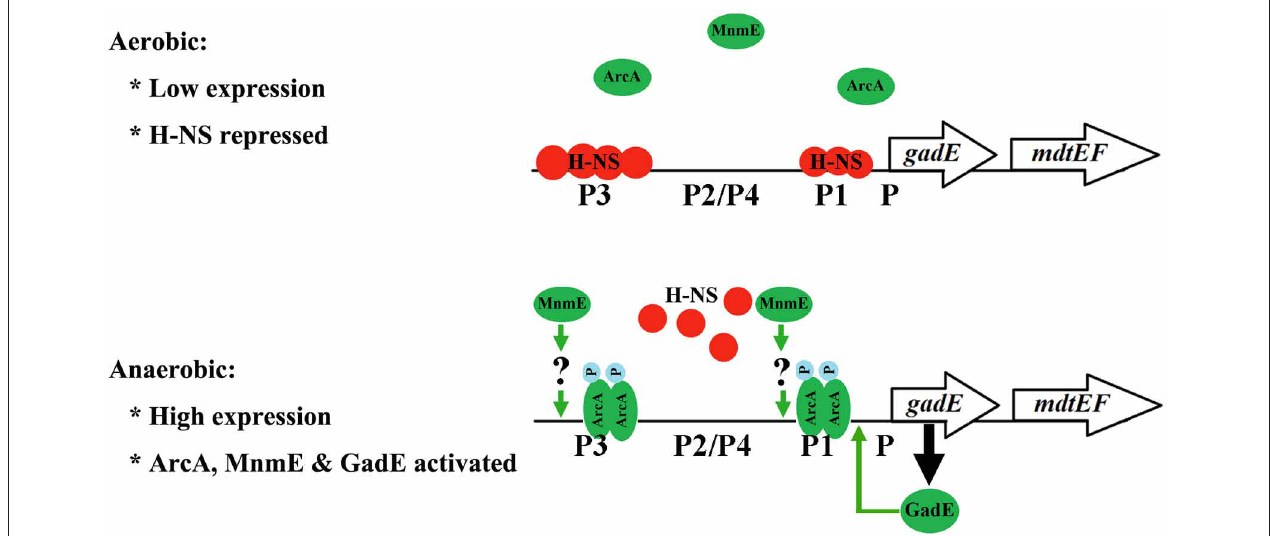
FIGURE 8 | A regulatory model for the transcriptional regulation of gadE-mdtEF operon during the transition from aerobic to anaerobic growth in minimal M9 glucose medium. During aerobic growth, the gadE-mdtEF is expressed at a very low level due to the strong repression by H-NS. Upon transition to anaerobiosis, the response regulator ArcA is phosphorylated and activated by its sensor kinase ArcB. Phosphorylated